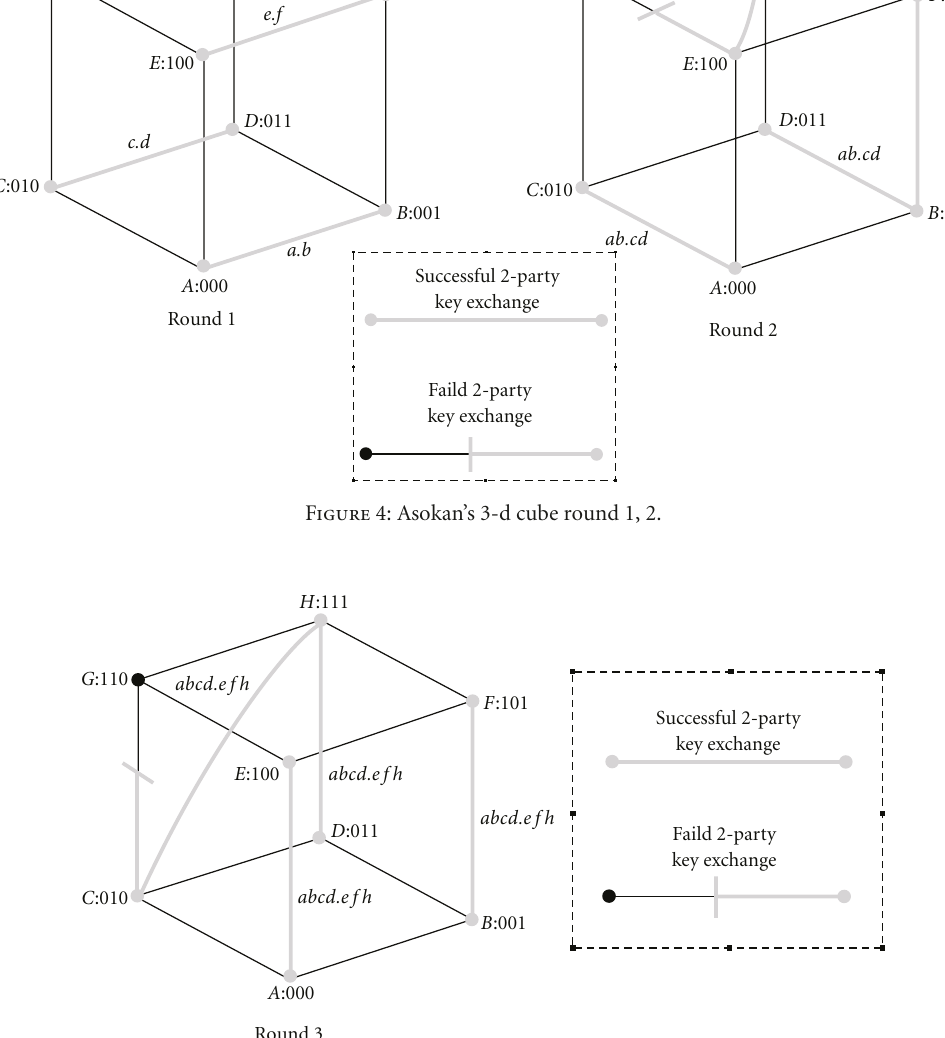
Figure 5: Asokan’s 3-d cube round